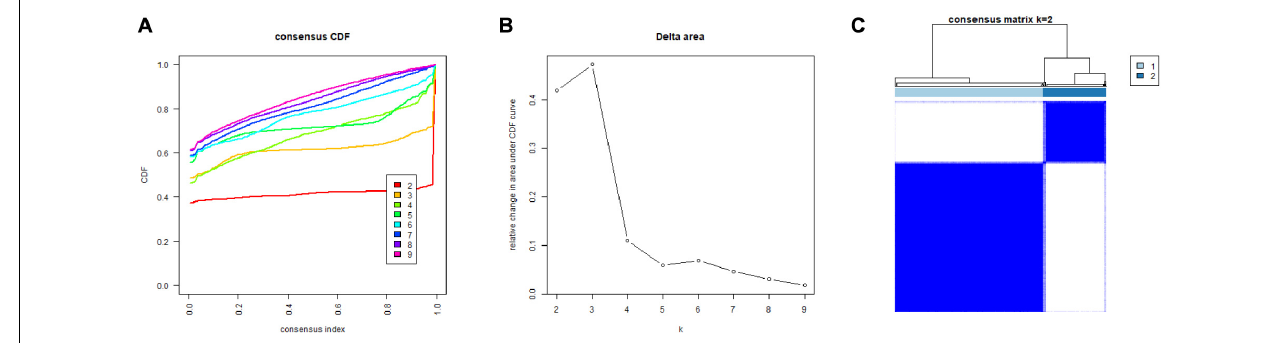
FIGURE 3 | Consensus clustering of m6A-related genes. (A) Cumulative distribution function (CDF) for LIHC. (B) The area under the CDF curve in LIHC. (C) Consensus clustering matrix for LIHC. LIHC, liver hepatocellular